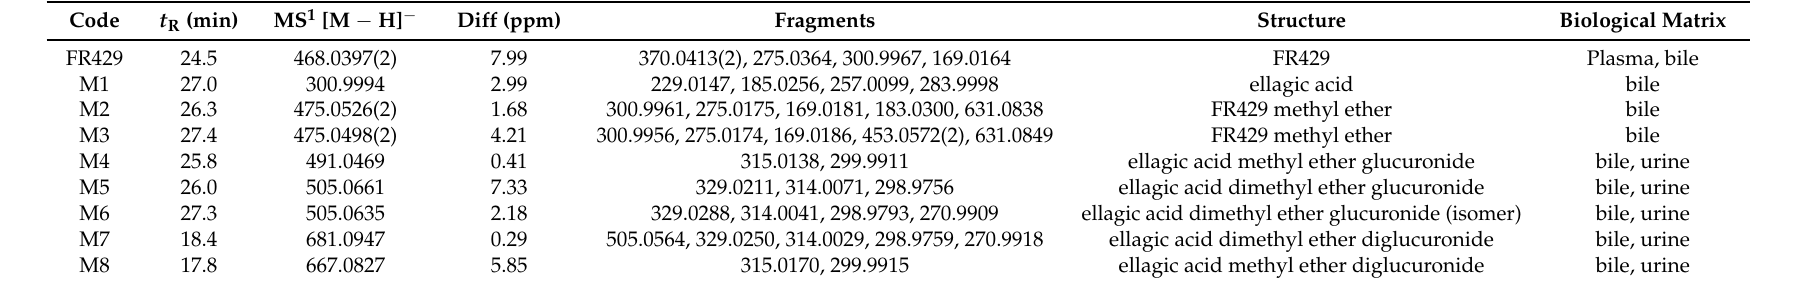
Table 1. LC/MS n data obtained for FR429 and its metabolites in